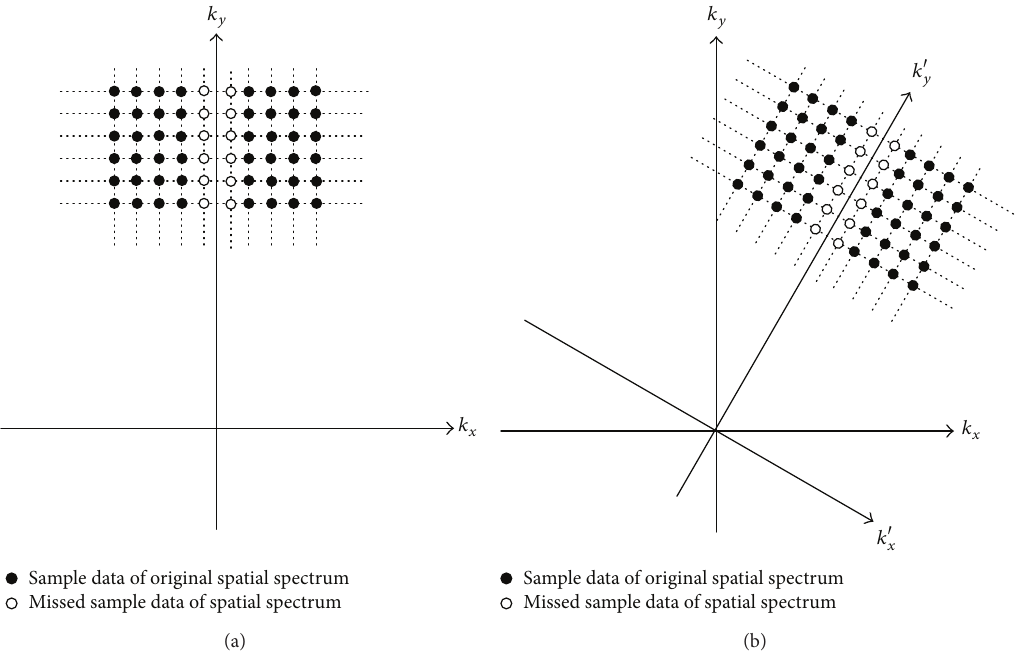
Figure 10: The missing sample data of the spatial spectrum can be estimated by the existing data. (a) The target is in the middle line of the array. (b) The target is not in the middle line of the array. In this situation, a transfer matrix is